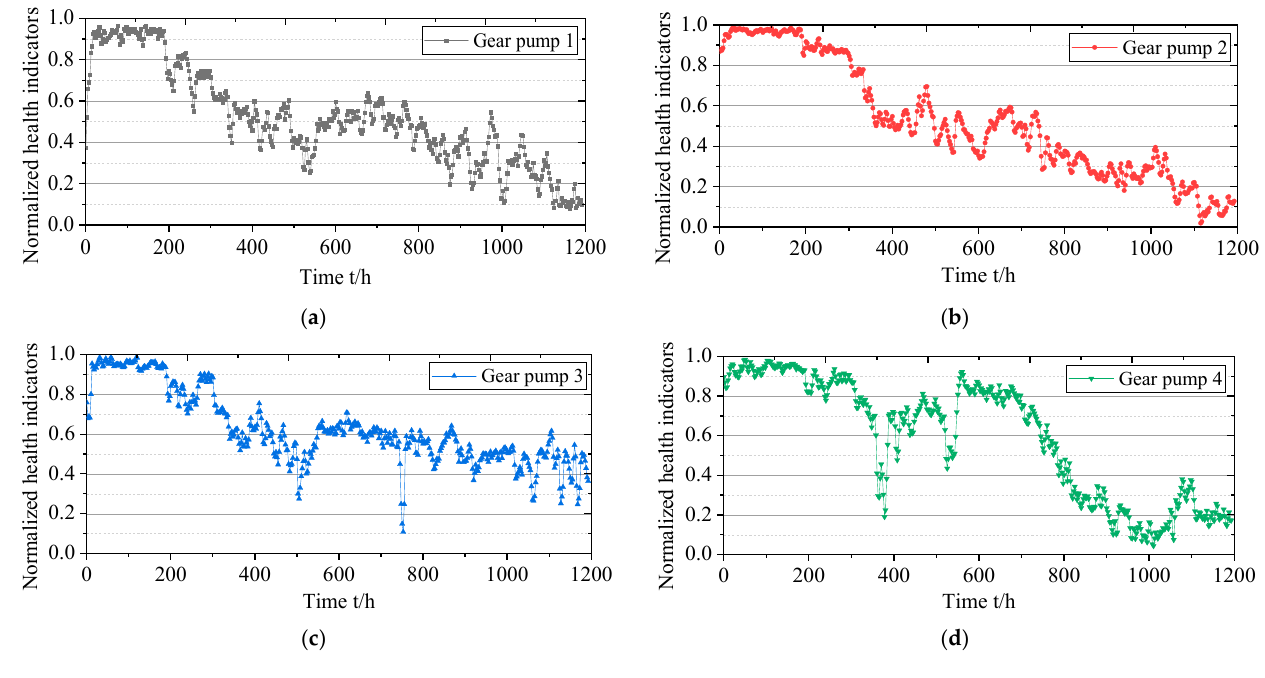
Figure 12. Normalized health indicators of four gear pumps: ( a ) gear pump 1; ( b ) gear pump 2; ( c ) gear pump 3; and ( d ) gear pump 4. Table 5. Comparative analysis of three evaluation indexes of health